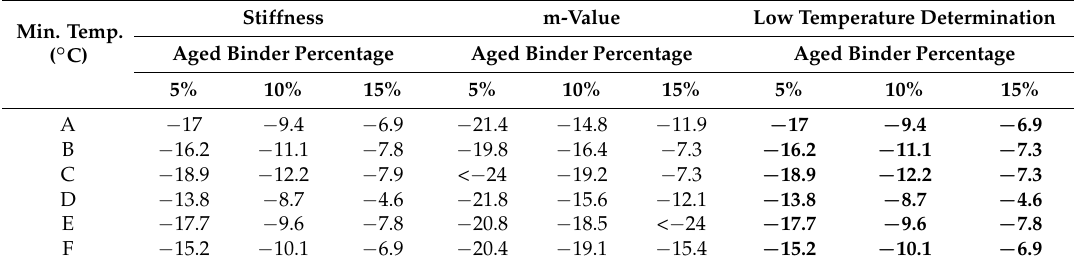
Table 3. Minimum low temperatures of RAP sources A–F with RTFO binder PG 58-28. Min.